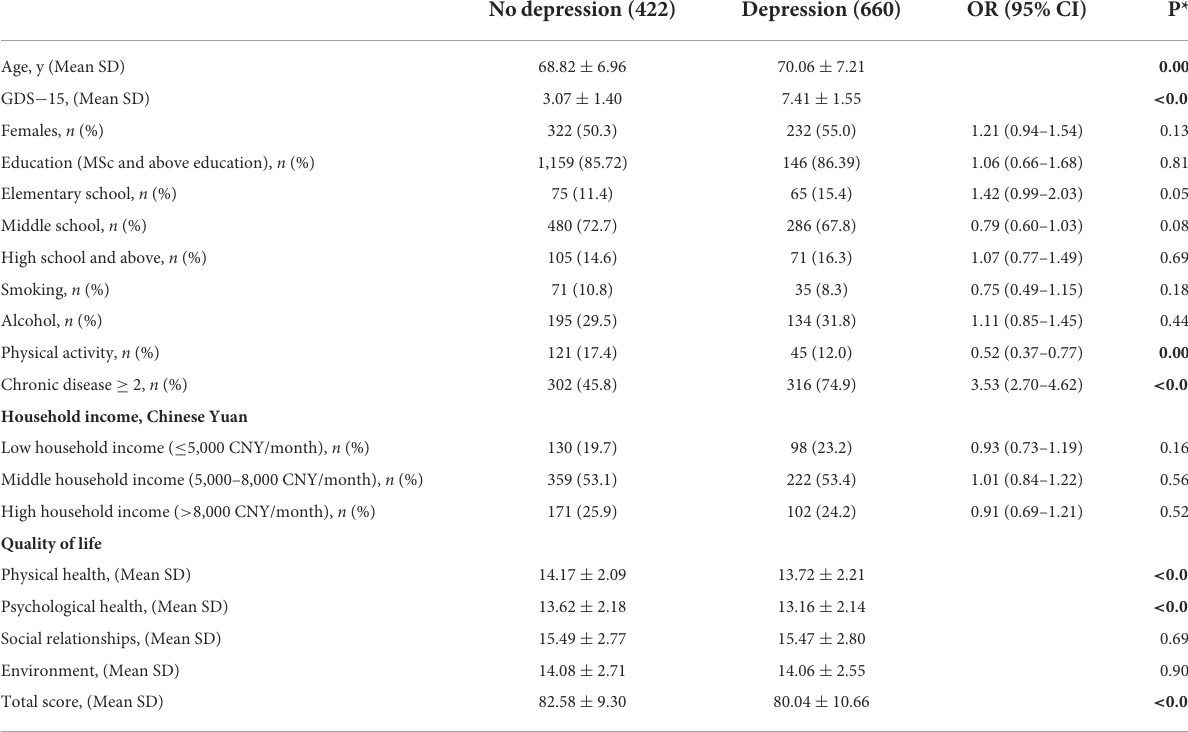
TABLE 4 Baseline characteristics between no depression and depression symptoms among empty-nest elderly.